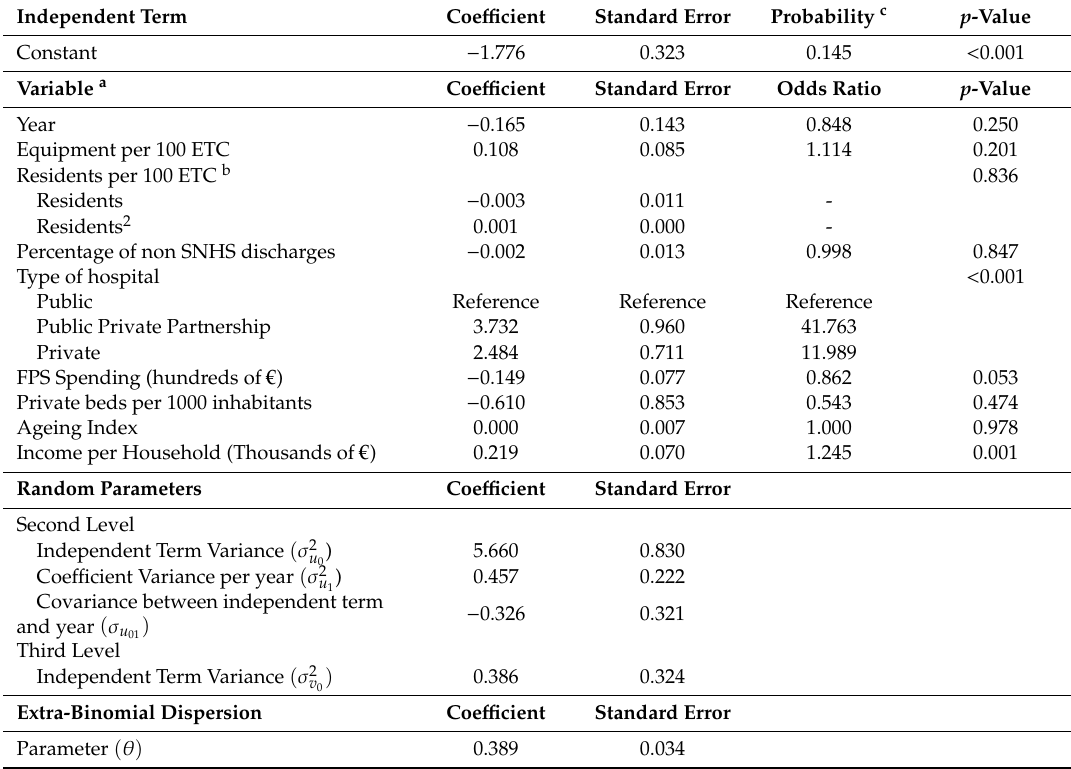
Table 5. Relationship between the type of ownership of Spanish National Health System general hospitals and position on the frontier of pure technical e ffi ciency.